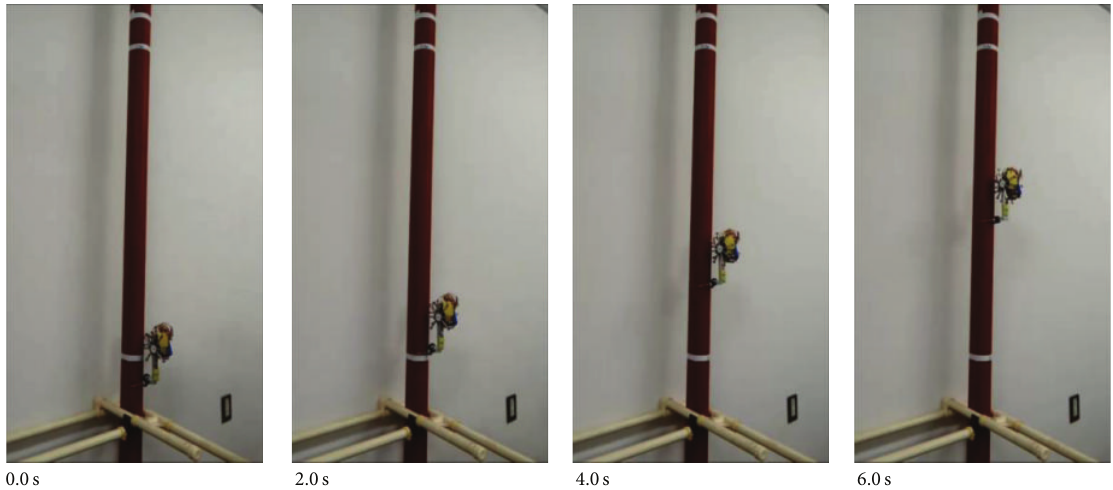
Figure 12: Robot moving vertically along a steel pipe.